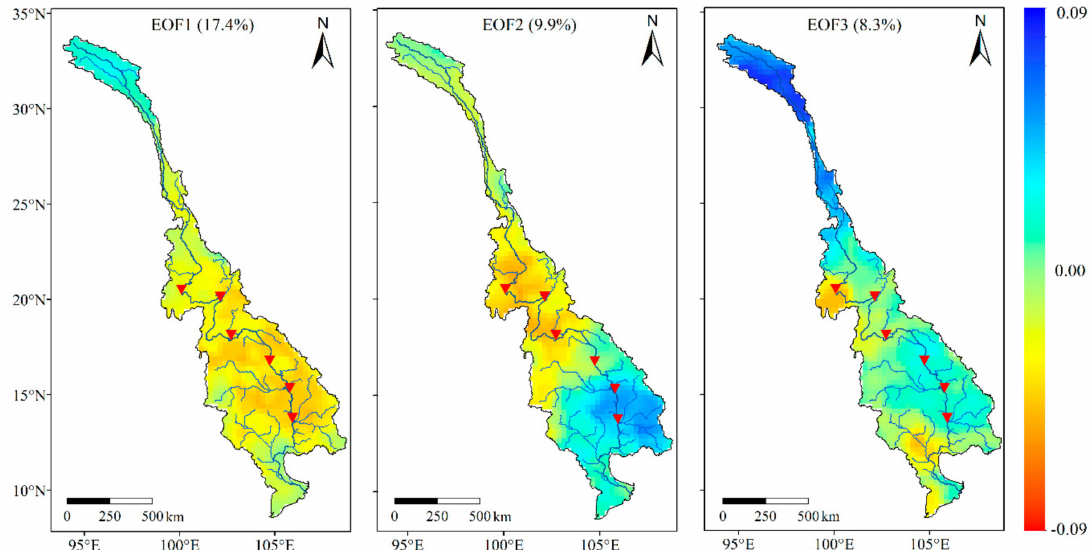
Figure 5. Spatial distributions of the first three empirical orthogonal function (EOF) modes during JJAS of 1951–2015.